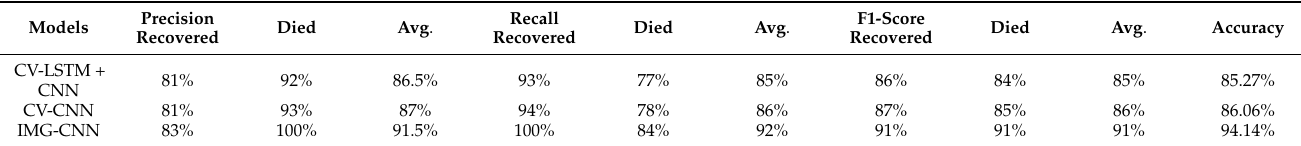
Table 9. Evaluation metrics for the three proposed Deep-Risk models.